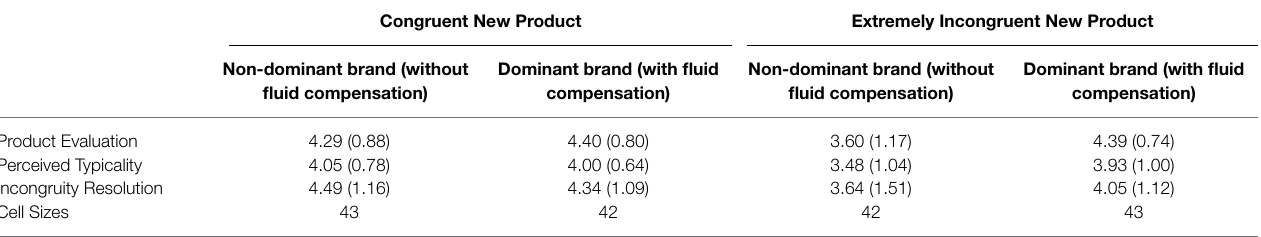
TABLE 4 | Pretest of vacuum